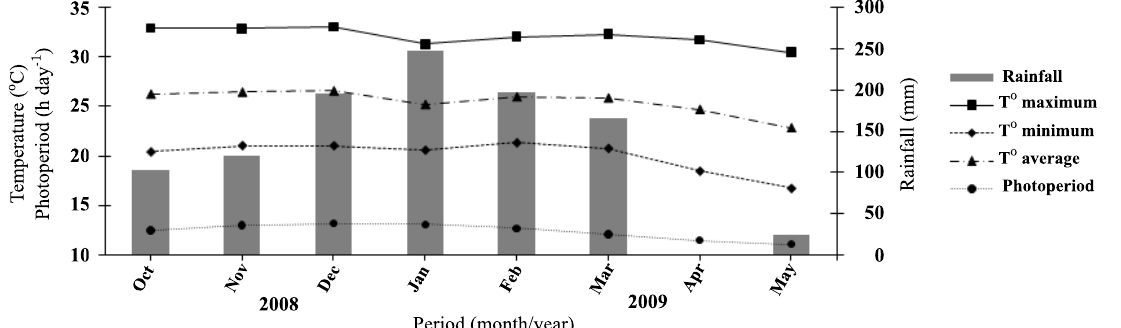
Figure 1. Climate data during the experimental period. Selvíria-MS. 2008 to